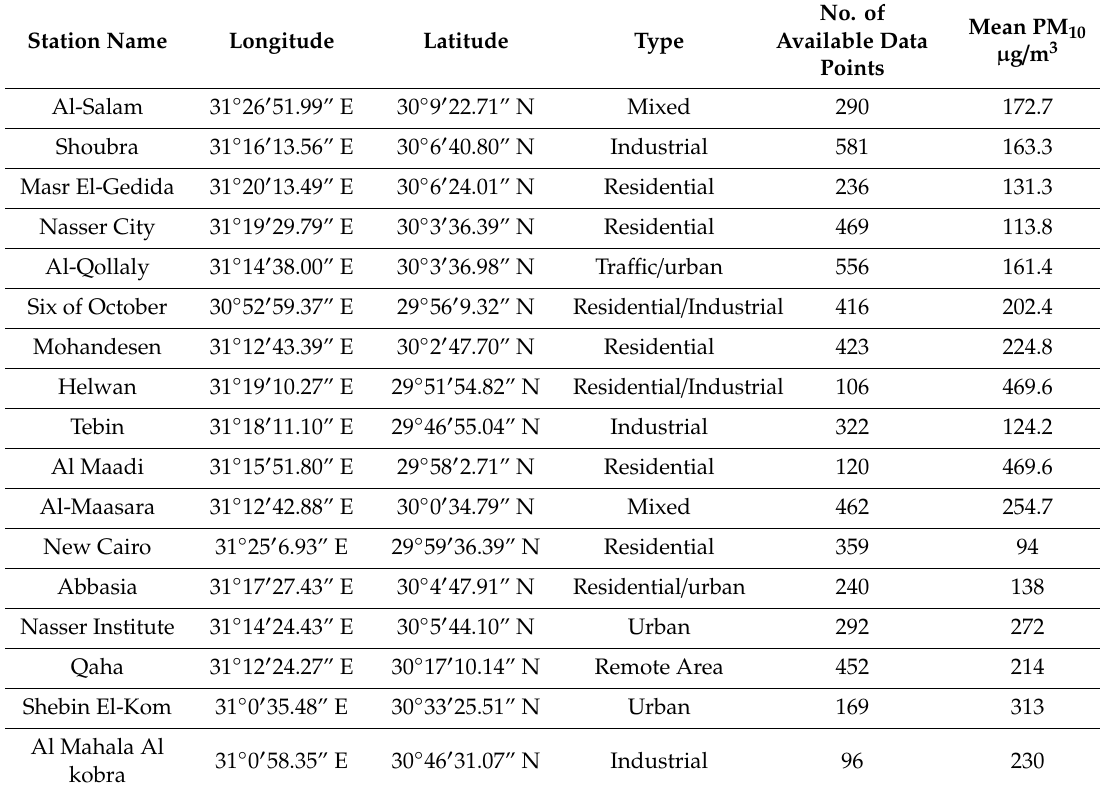
Table 2. Characterization of the environmental monitoring stations a ffi liated to Egyptian Environmental A ff airs Agency (EEAA) used as a reference for PM 10 measurements in